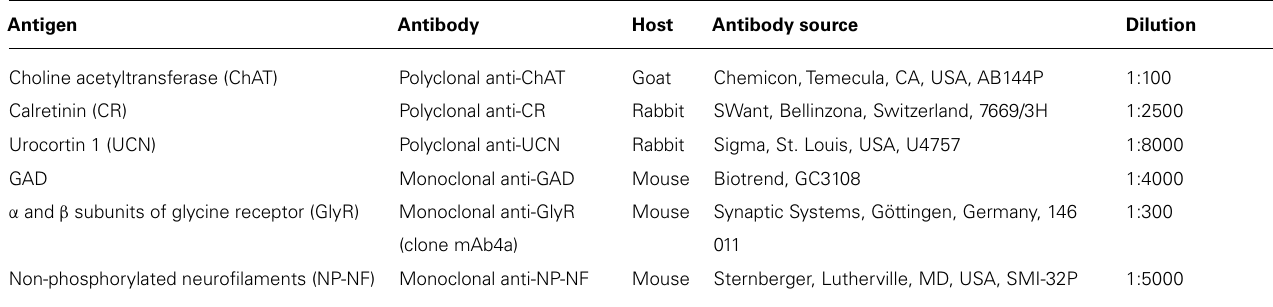
Table 1 | Sources and dilutions of primary